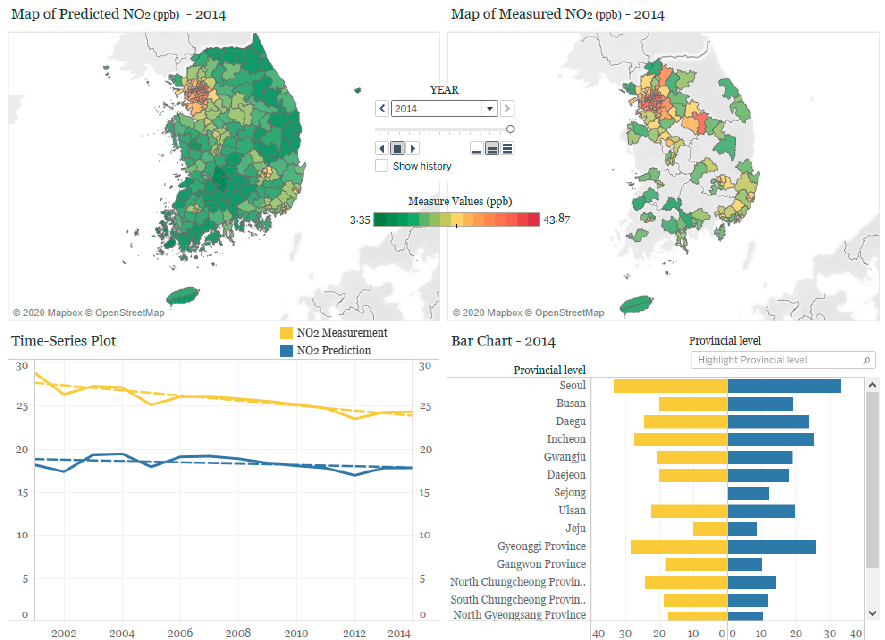
Figure 3. An example of the Tableau dashboard for visualizing measured and predicted annual average nitrogen dioxide (NO 2 ) concentrations in South Korea, 2001–2014 (maps presented above show the concentrations for the year 2014 selected on the ‘pages shelf’ and can be replaced with concentrations in any specific year when